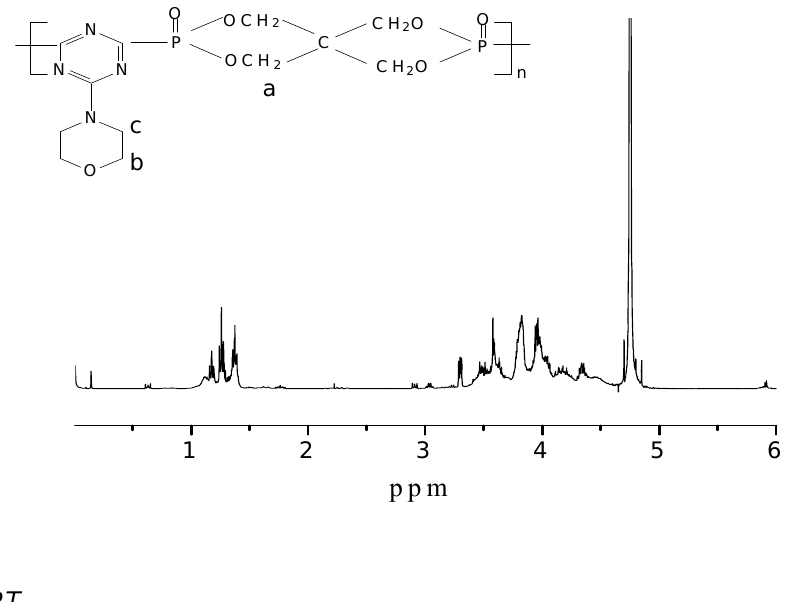
Figure 4. 1 H-NMR spectrum of phosphorus-containing triazine oligomer PMPT.